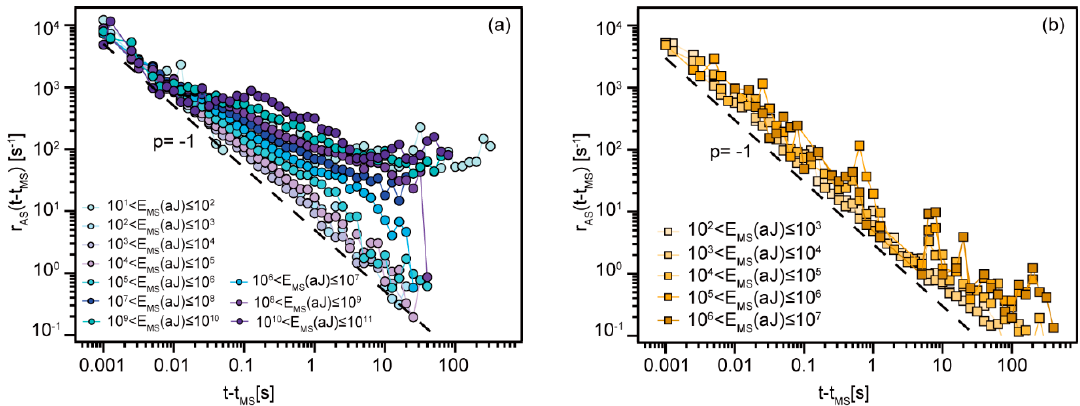
Figure 6. Rate of aftershocks per unit time, r, as function of the time lapse to the main shock for different main shock energy levels. The black dashed line indicates the Omori’s behavior with slope = − 1, ( a ) for non-tectonic and ( b ) tectonic coal.